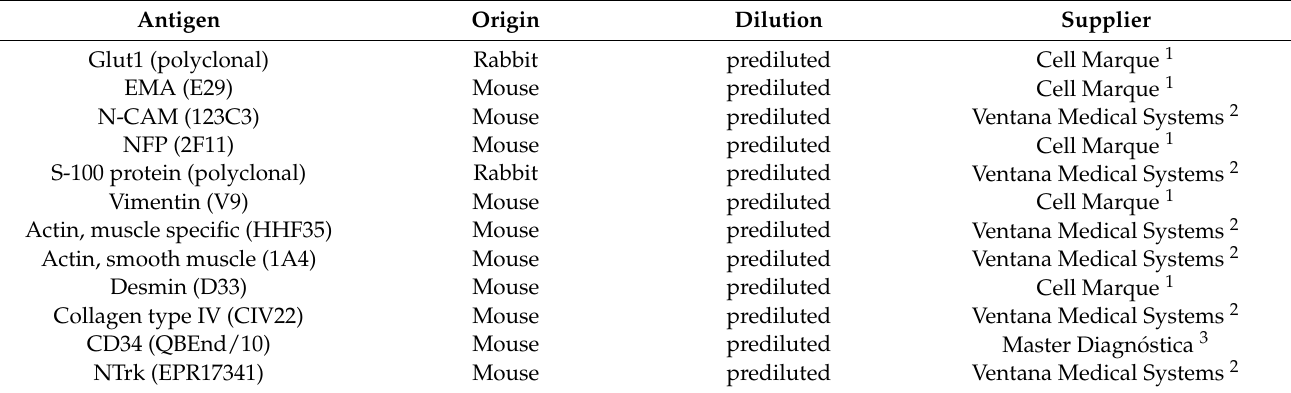
Table 1. Primary antibodies used in the study.